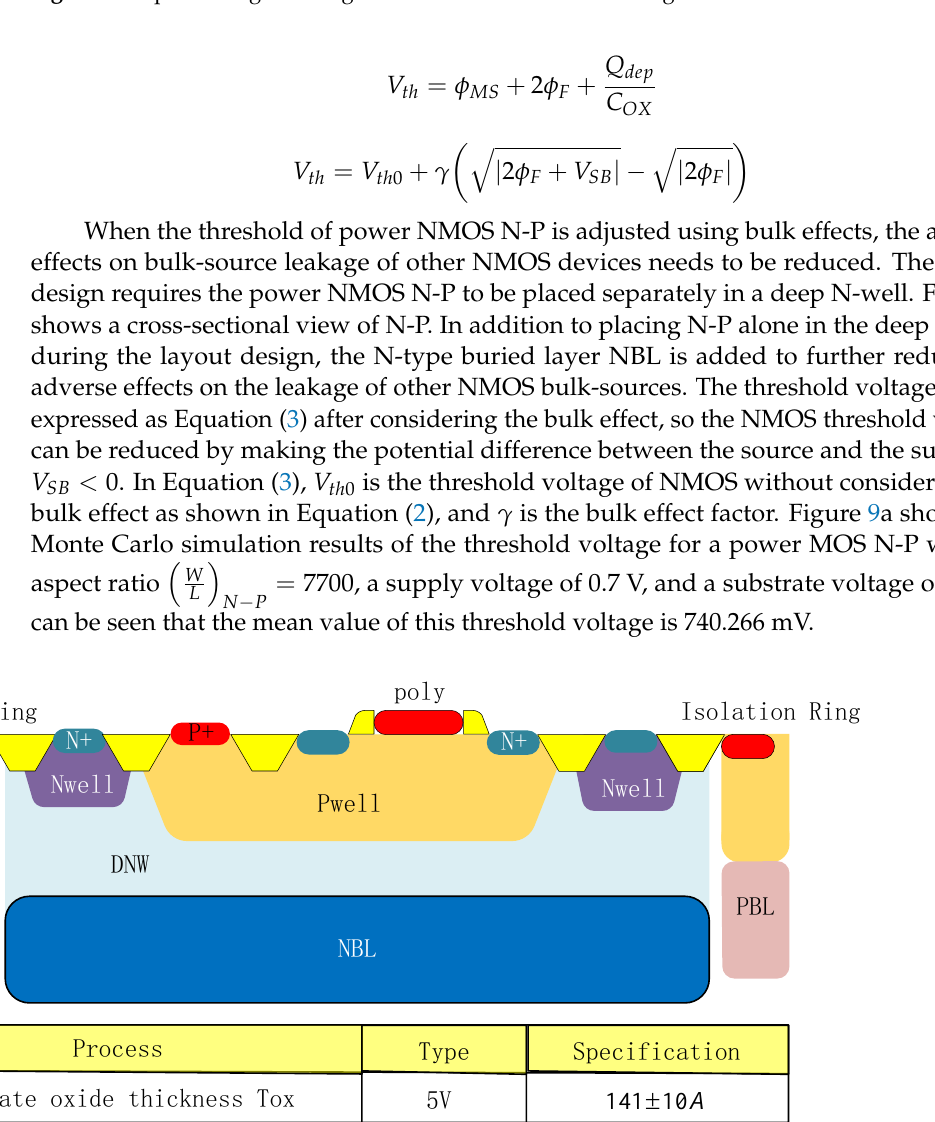
Figure 7. Depletion region charge variation with substrate voltage.